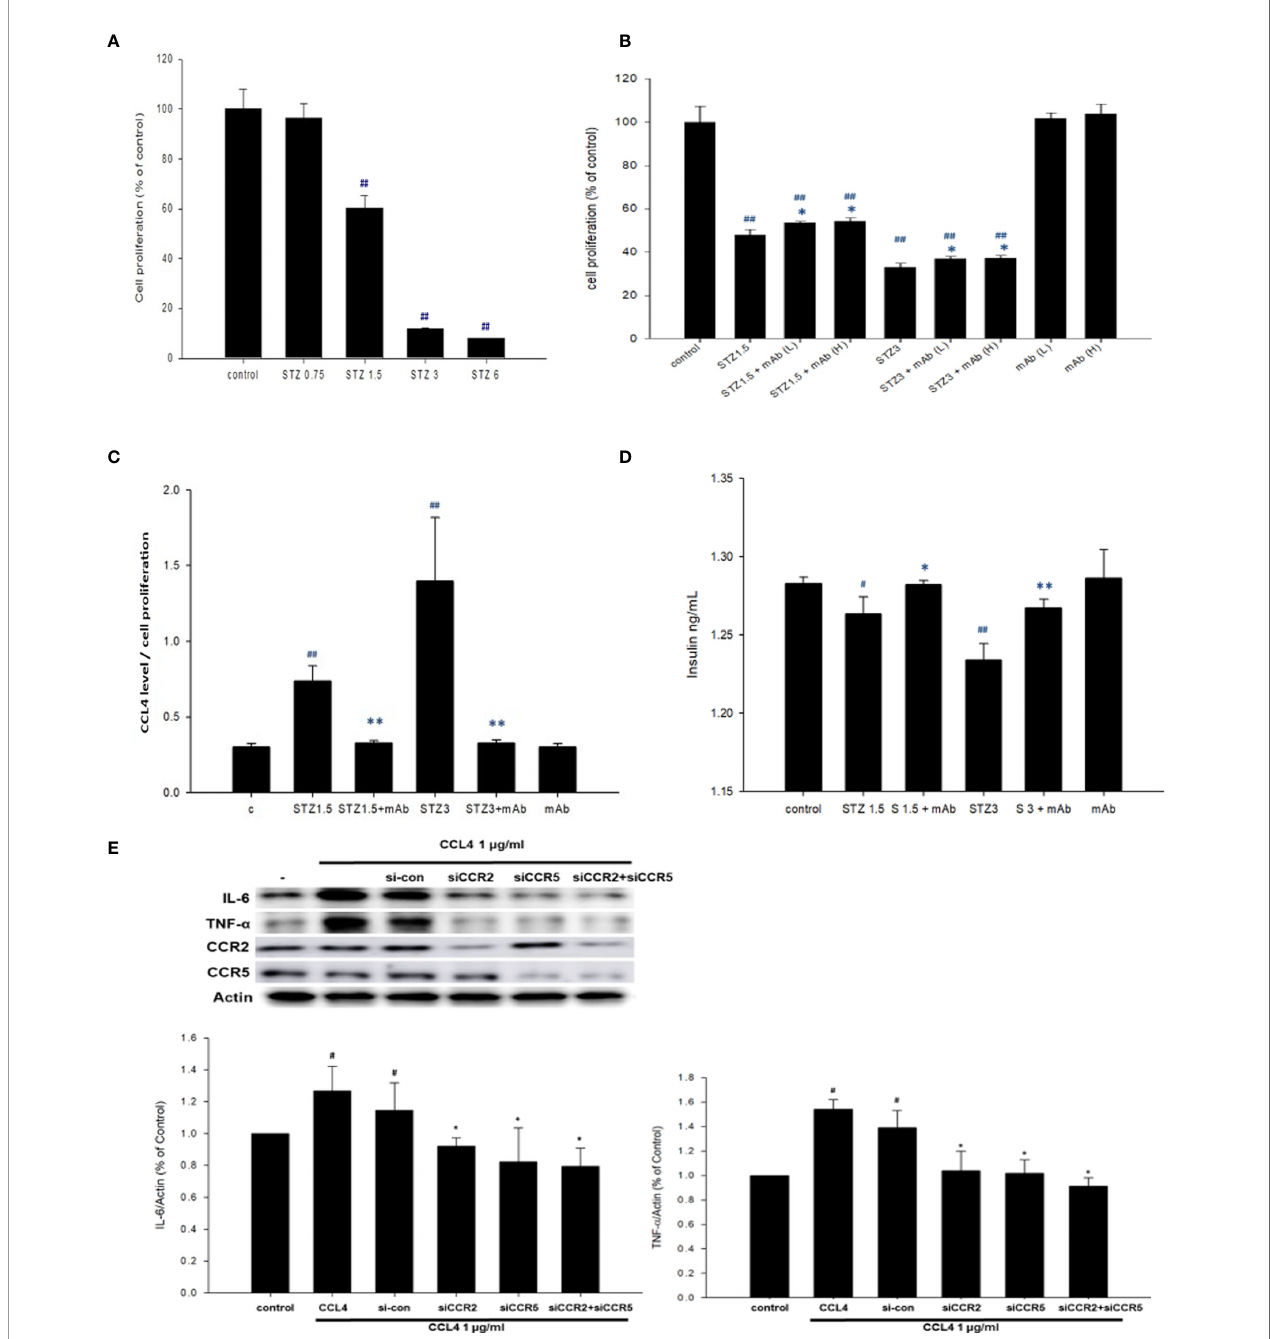
FIGURE 2 | The effects of CCL4 on in fl ammation modulation in pancreatic b -cells. NIT-1 cell proliferation after STZ treatments at different doses (n=3; A ). STZ- treated NIT-1 cells were then incubated with the CCL4 mAb at a low dose (L) and high dose (H). NIT-1 cell proliferation was evaluated using an MTT assay (n=3; B ). The CCL4 levels in the supernatants of NIT-1 cells were standardized by the average MTT assay data (n=6; C ). Insulin levels in the supernatants of NIT-1 cells (n=6; D ). Western blot and statistical analyses of IL-6 and TNF- a expression in NIT-1 cells (n=3; E ). # P<0.05 , ## P<0.01 compared with the control group of NIT-1 cells. *P<0.05 , ** P<0.01 compared with the same STZ concentration-treated or CCL4-treated NIT-1 cell